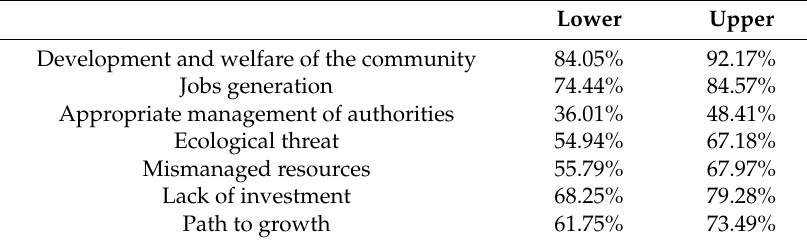
Table 4. Opinions of the industrial park, statistical